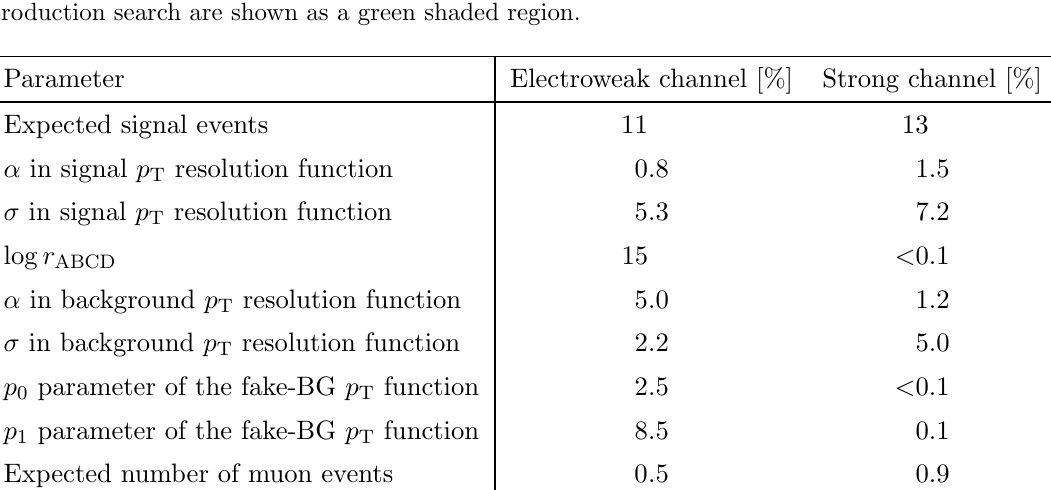
Table 5 . E(cid:11)ects of systematic uncertainties on the signal exclusion signi(cid:12)cance at m for the electroweak channel and at m ~ g = 1600 GeV, m lifetime of the chargino is not relevant here. E(cid:11)ects of uncertainties on the fake-tracklet back- ground is smaller in the strong channel analysis because the estimated number of the fake-tracklet background events is small.